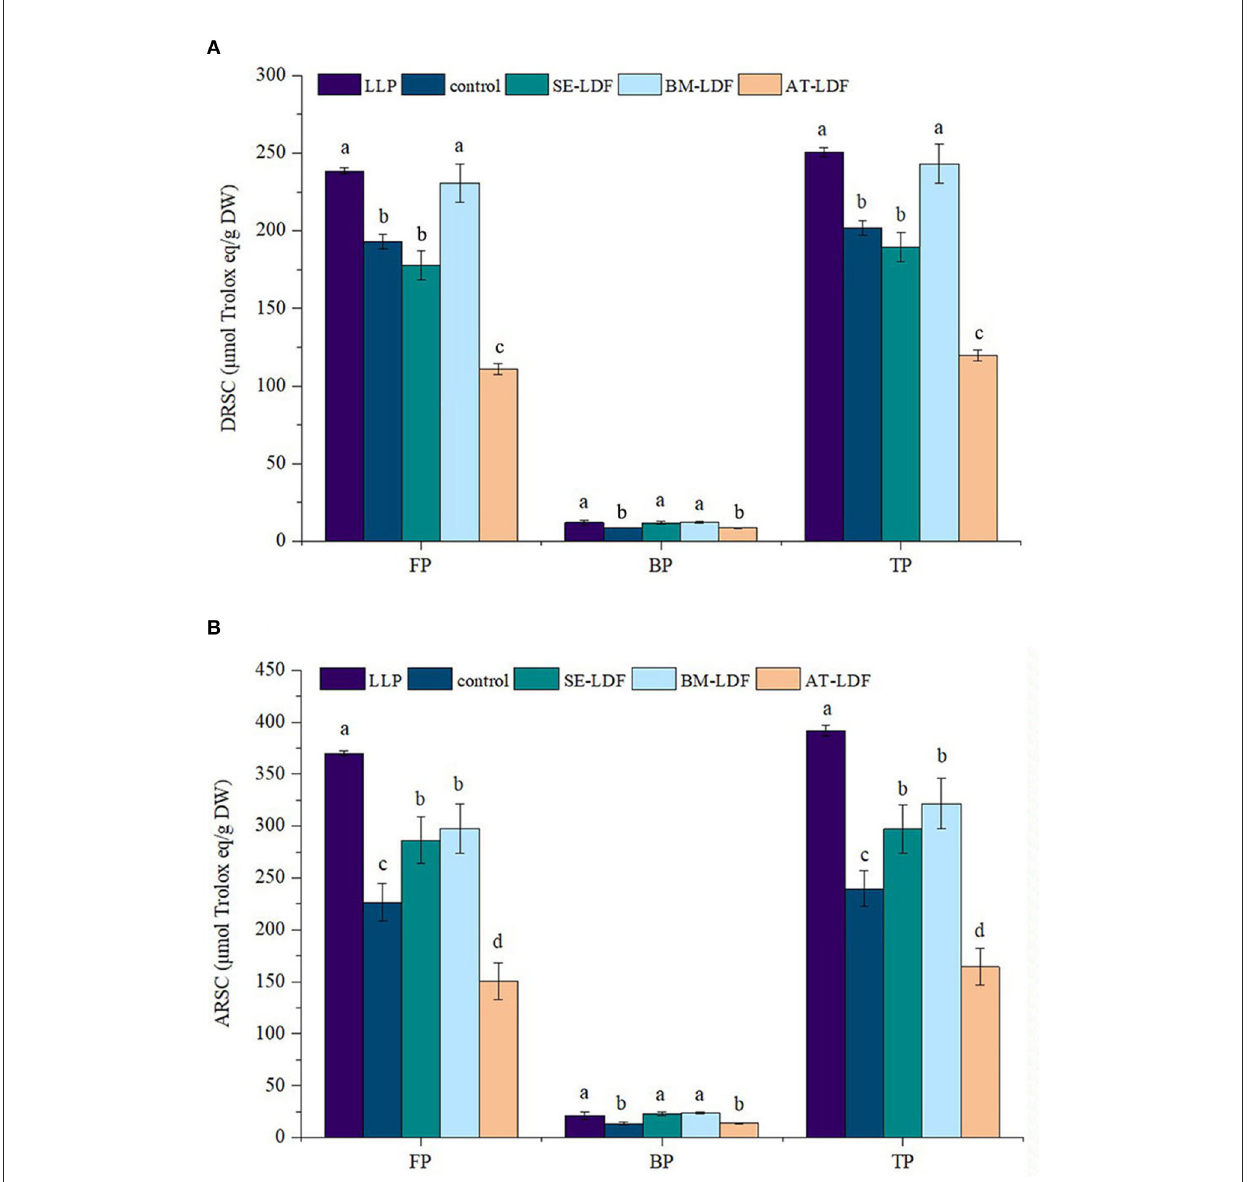
FIGURE7 DRSC and ARSC of FP, BP, and TP in LLP and LDFs. (A) DRSC, DPPH free radical scavenging capacity; (B) ARSC, ABTS free radical scavenging capacity. All values were means ± sd, n = 3. Values with different letters were significantly different in the same group, P < 0.05. FP, free phenolic; BP, bound phenolic; TP, total phenolic. LLP, lotus leaves powder; control, lotus leaves dietary fiber; SE-LDF, shear emulsifying modified lotus leaves dietary fiber; BM-LDF, ball milling modified lotus leaves dietary fiber; AT-LDF, autoclave modified lotus leaves dietary